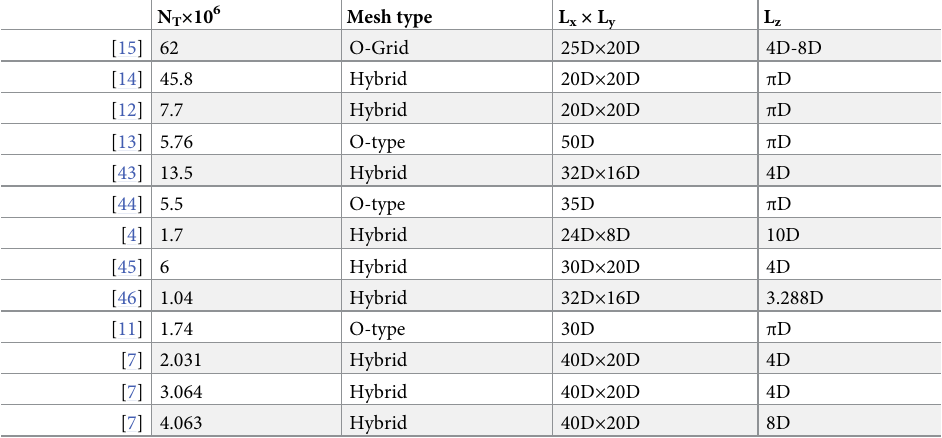
Table 1. Mesh details and boundary conditions used in